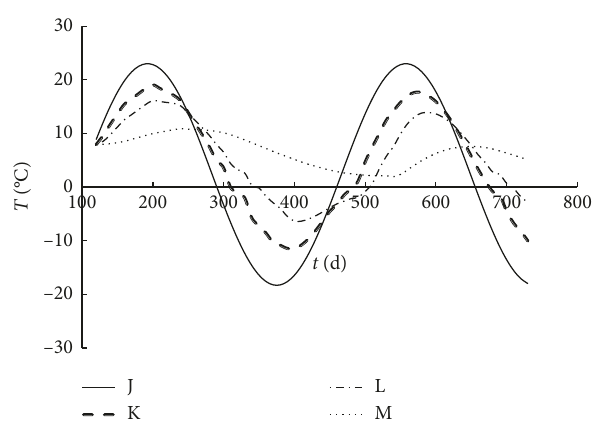
Figure 8: Variation in the slope temperature at different